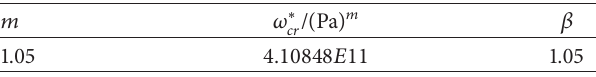
Table 1: Material properties in damage evolution equation for mate- rial 35Cr2Ni4MoA with 𝐾 𝑇 = 1 .